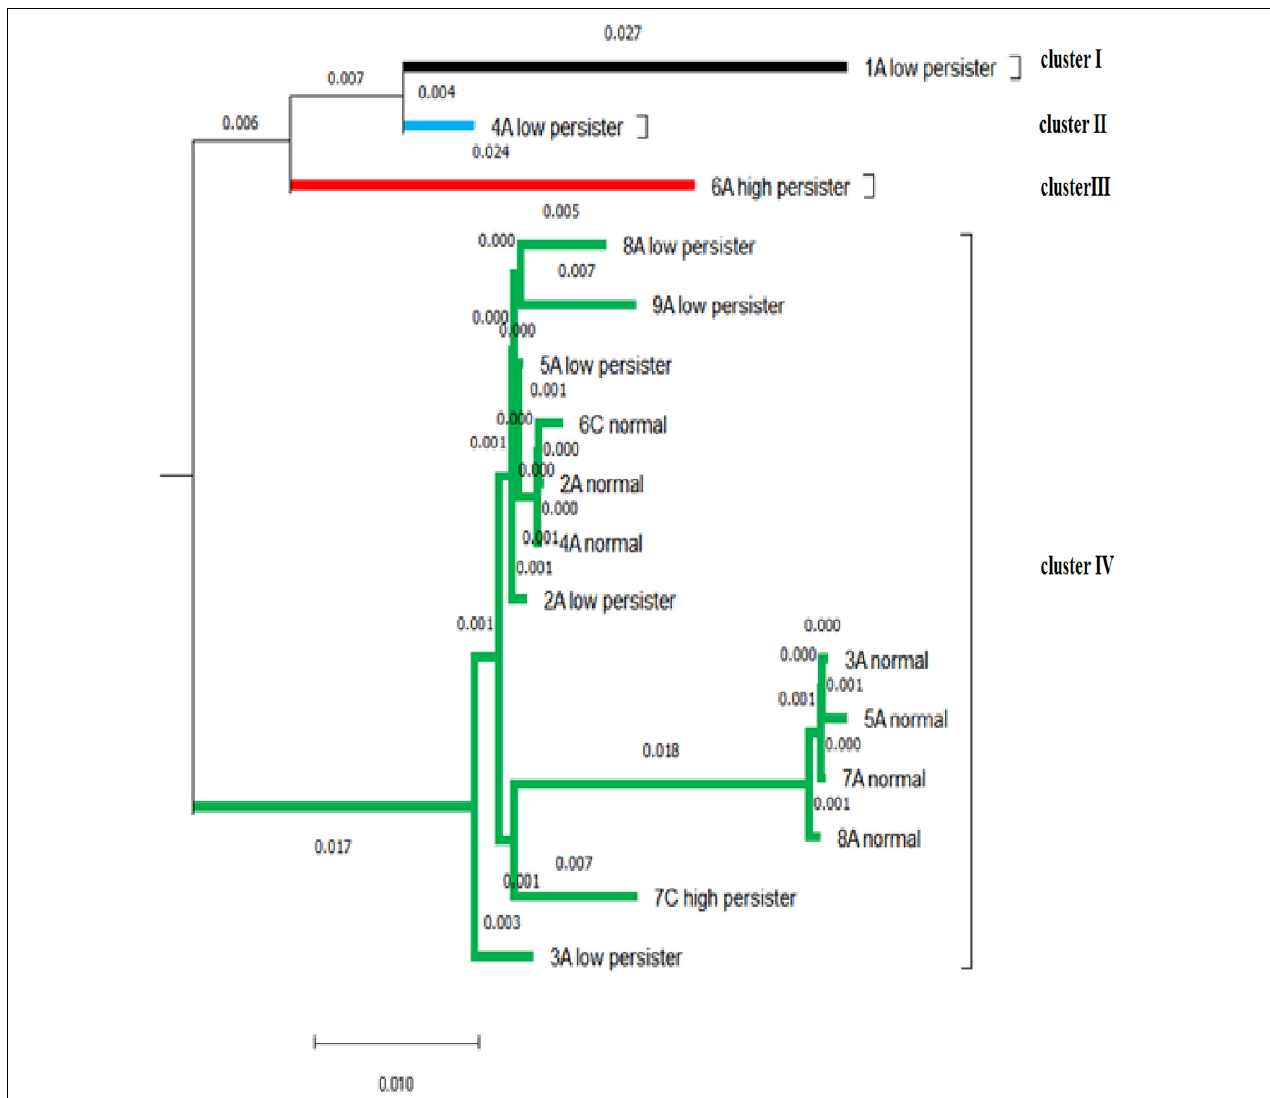
FIGURE 6 | Based on the mean pairwise distance of 0.029, the phylogenetic tree of the isolates shows four